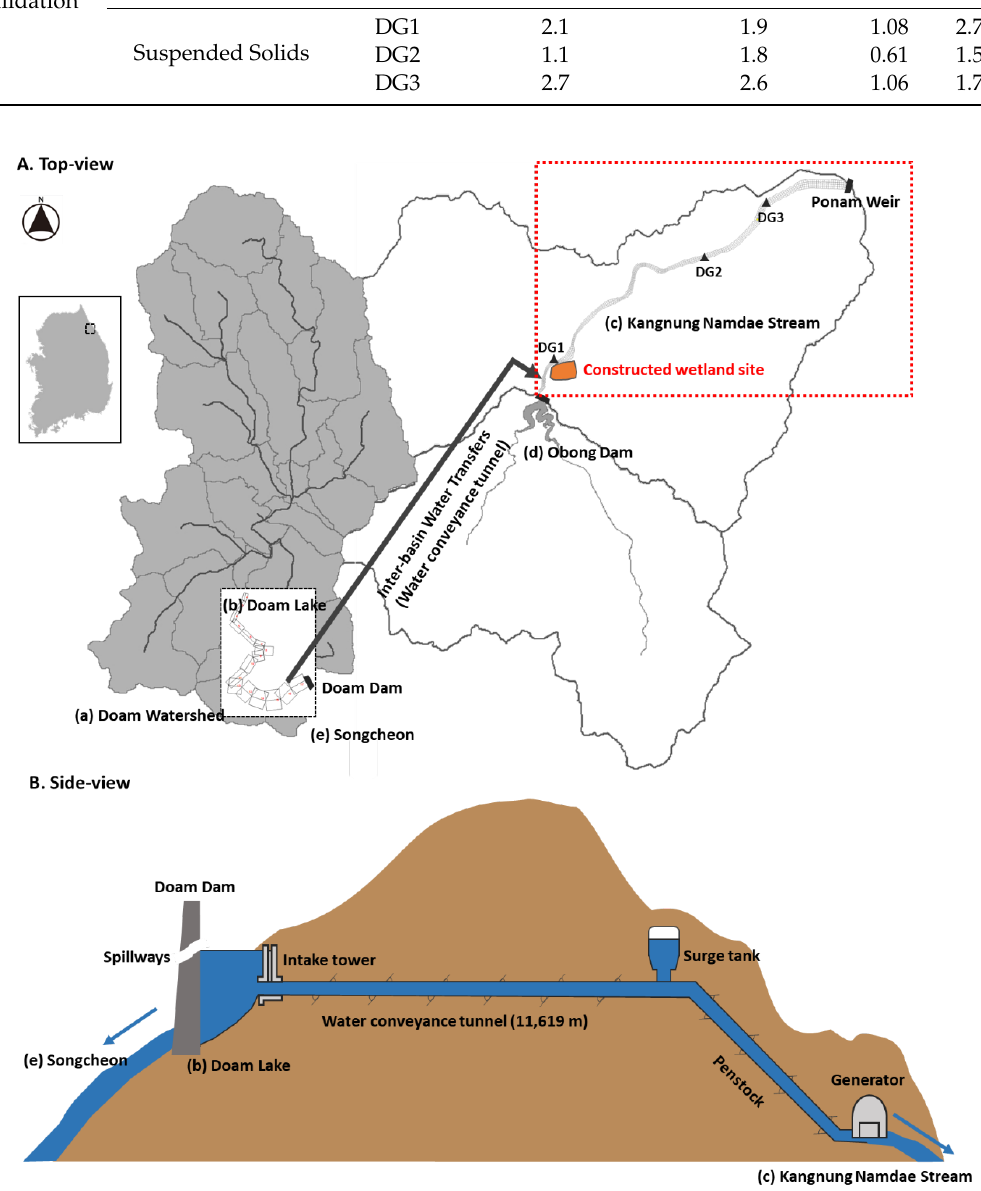
Figure 1. Thematic geographic information system maps and monitoring sites of the study area. ( A ) Top-view of study area: (a) the watershed model (HSPF) sub-basin map of the Doam Lake watershed, (b) reservoir model (CE-QUAL-W2) segment definition map of Doam Lake, and (c) stream model (EFDC) grids of Kangnung Namdae Stream (red dotted box). ( B ) Side-view of study area.